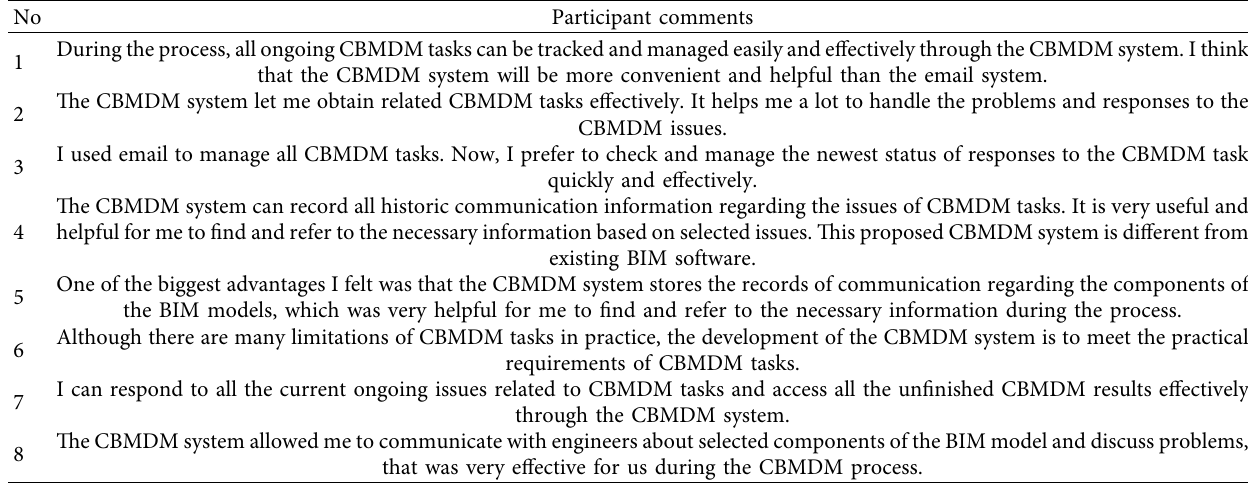
Table 4: Evaluation comments from participating BIM